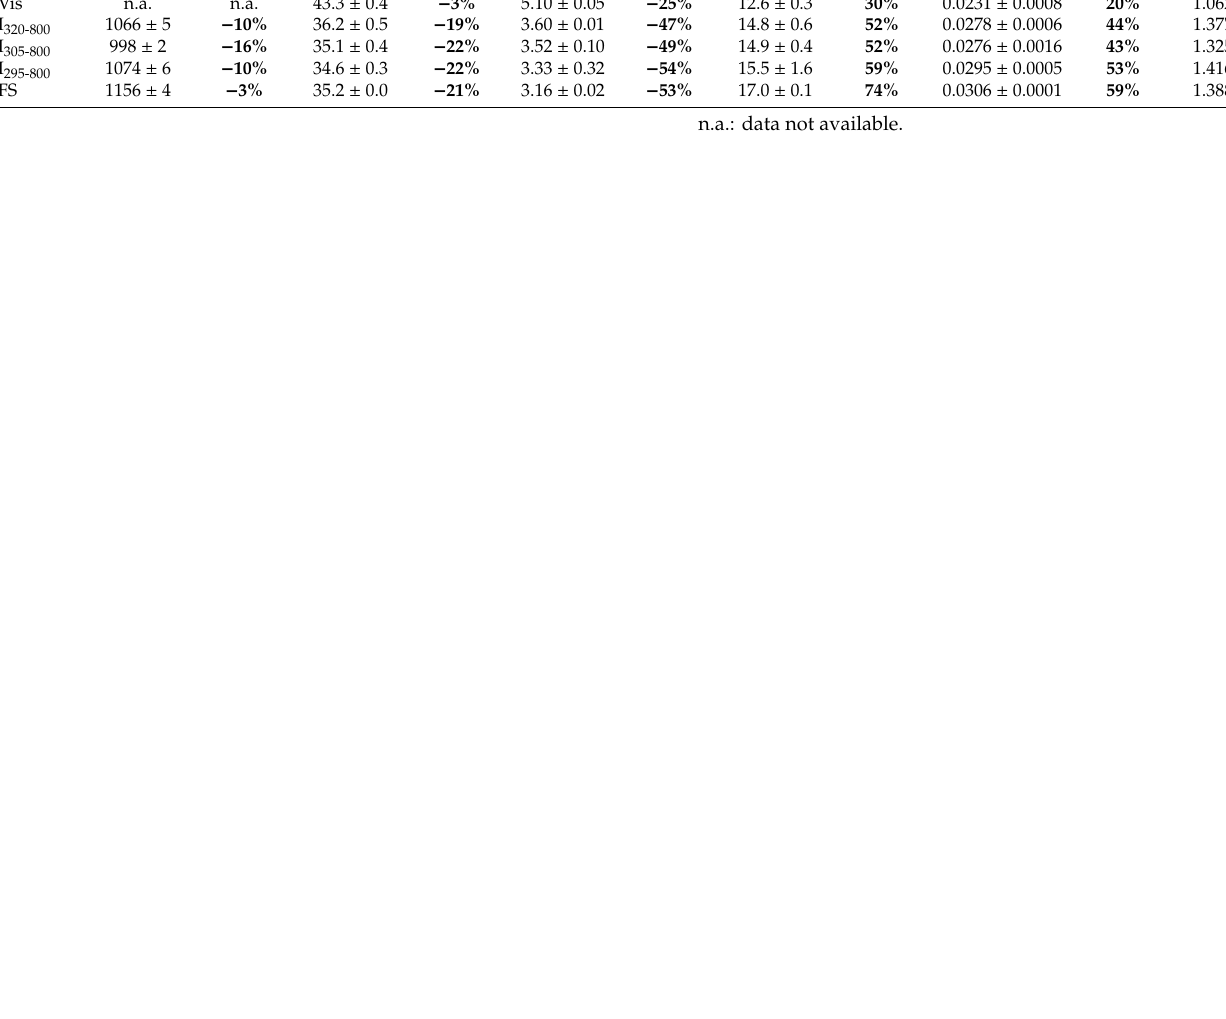
Table 1. Values of CDOM absorption indices before and after irradiation with di ff erent cuto ff filters. ∆ % indicates the di ff erence between the irradiated sample and the non-irradiated one. The values refer to the average and standard deviation between the replicates. DOC ( µ M) a 254 (m − 1 ) a 350 (m − 1 ) MS (a 250 / a 365 ) S 275-295 (nm − 1 ) Sr SUVA 254 (m 2 g − 1 C) ± ± ± ± ± ± Average ± ∆ % Average ∆ % Average ∆ % Average ∆ % Average ∆ % Average ∆ % Average st. dev. st. dev. st. dev. st. dev. st. dev. st. dev. st.